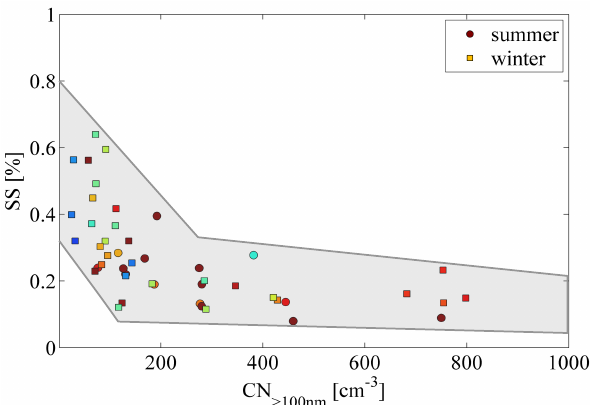
Fig. 16. Cloud maximum supersaturation (y-axis) as a function